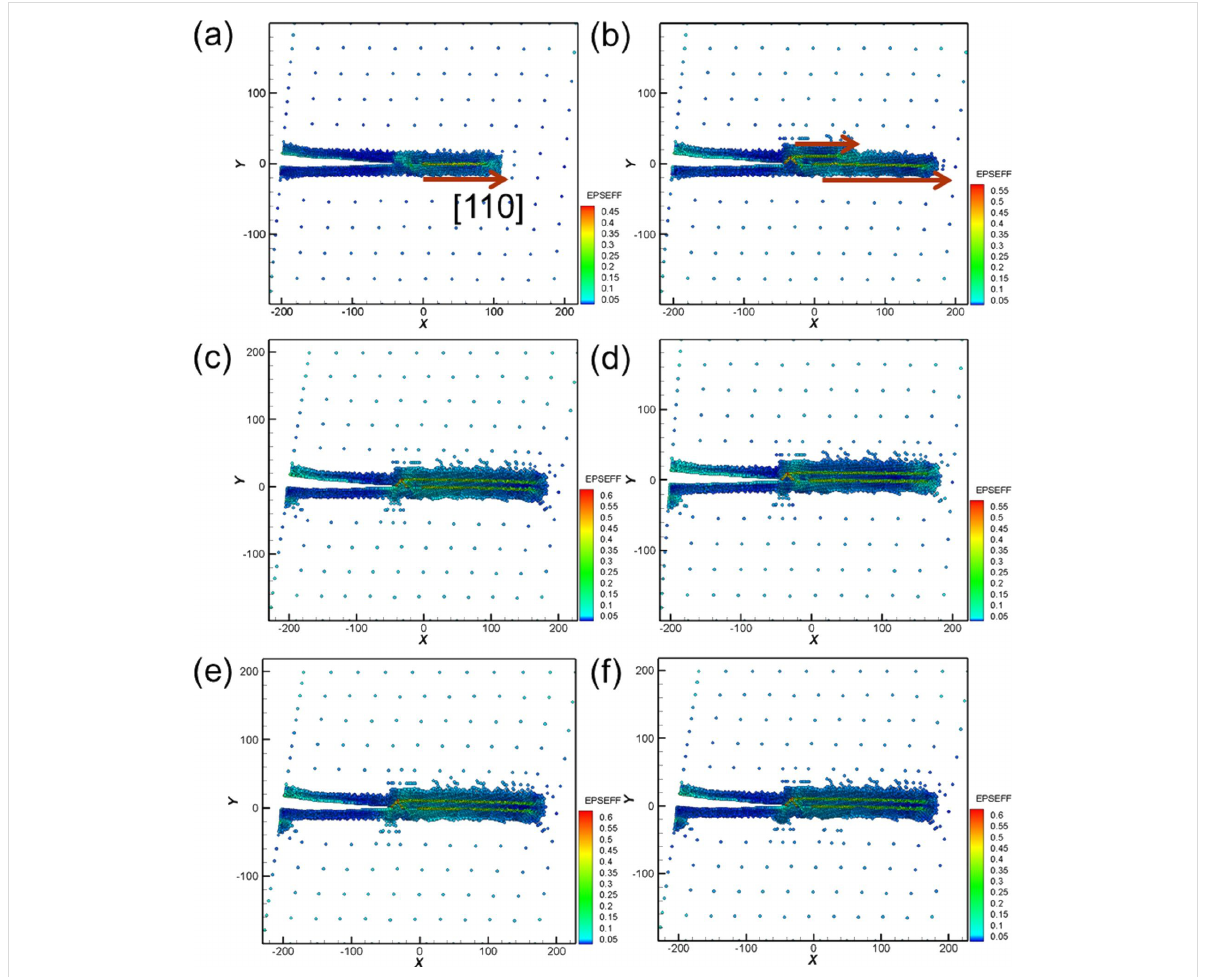
Figure 14: Crack growth and expansion diagrams of Ni corresponding to the observation positions a–f in Figure 13.